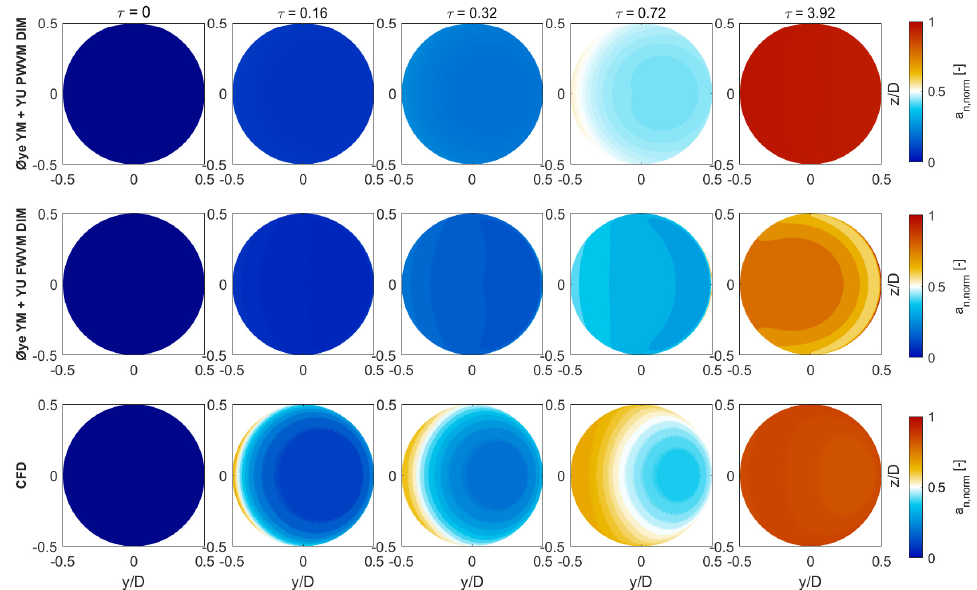
Figure 15. Comparison of normalized induction field a n , norm from different models and τ when base C T = 0.6, step ∆ C T = +0.1, Φ y = 30